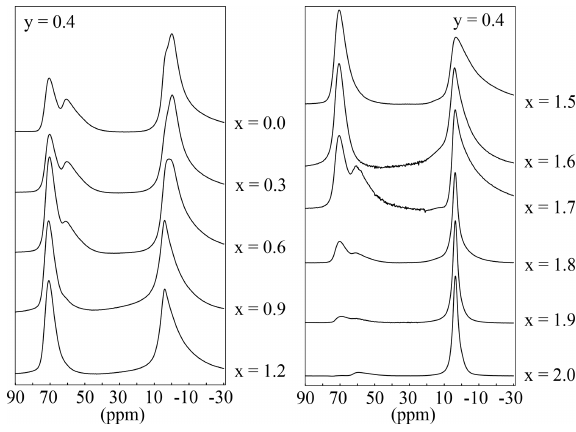
Figure 12. 27 Al MAS NMR spectra with variable Li content and an OH content of y = 0 . 4. The position of the tetrahedral signal is at 73(3)ppm and that of the octahedral at